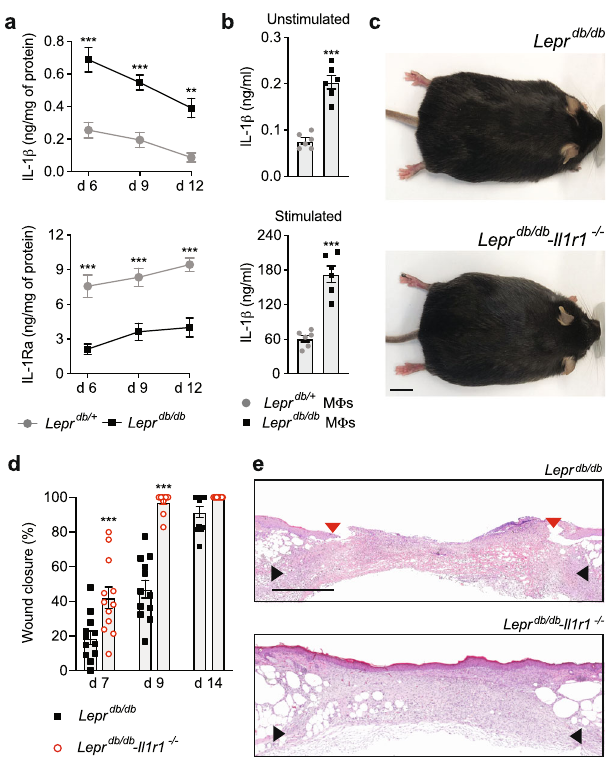
Fig. 1 IL-1R1 signalling delays wound healing in diabetic mice. a Full- thickness wounds (5 mm) were created in diabetic mice ( Lepr db/db ) and non-diabetic littermates ( Lepr db/ + ). Concentrations of IL-1 β and IL-1Ra in wounds harvested at various time points. n = 4 wounds per time point. b Concentrations of IL-1 β detected in media of unstimulated or stimulated (LPS + ATP) bone marrow-derived macrophages (M Φ s) from Lepr db/ + and Lepr db/db mice. c Lepr db/db mice were crossed with Il1r1 − / − mice to generate diabetic mice de fi cient for IL-1R1. Representative pictures of 14-week-old mice are shown. Scale bar = 1 cm. d , e Full-thickness wounds were created in Lepr db/db and Lepr db/db -Il1r1 − / − mice. Graph in d shows wound closure kinetics evaluated by histomorphometric analysis of tissue sections. n = 12 wounds per time point. Representative histology (haematoxylin and eosin staining) after 9 days are shown in ( e ). Black arrows indicate wound edges and red arrows indicate tips of epithelium tongue. The epithelium (if any) appears in purple as a homogeneous keratinocyte layer on top of the wounds. The granulation tissue under the epithelium contains granulocytes with dark-purple nuclei. Fat tissue appears as transparent bubbles. Scale bar = 1 mm. For ( a ), ( b ) and ( c ), data are means ± SEM. For ( a ) and ( d ), two-way ANOVA with Bonferroni post hoc test for pair-wise